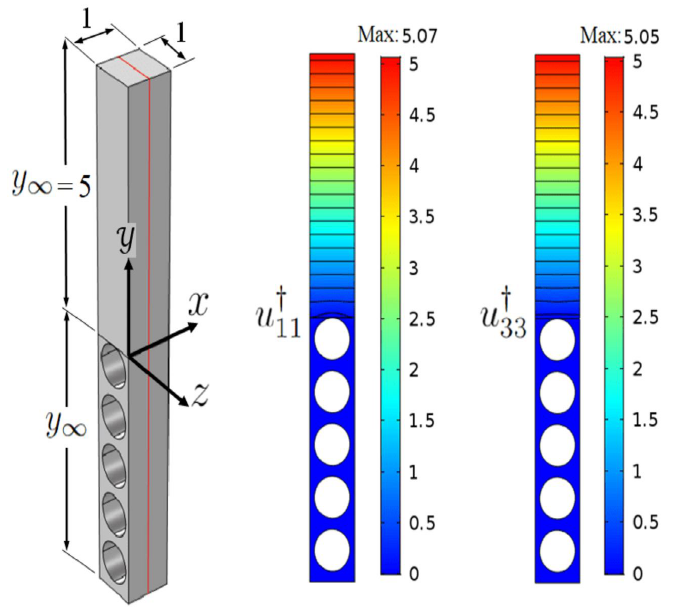
Figure 2. A full microscopic domain (in grey) with two-dimensional zy − plane (in red) over which contours of u † and u † are shown, for θ = 33 11